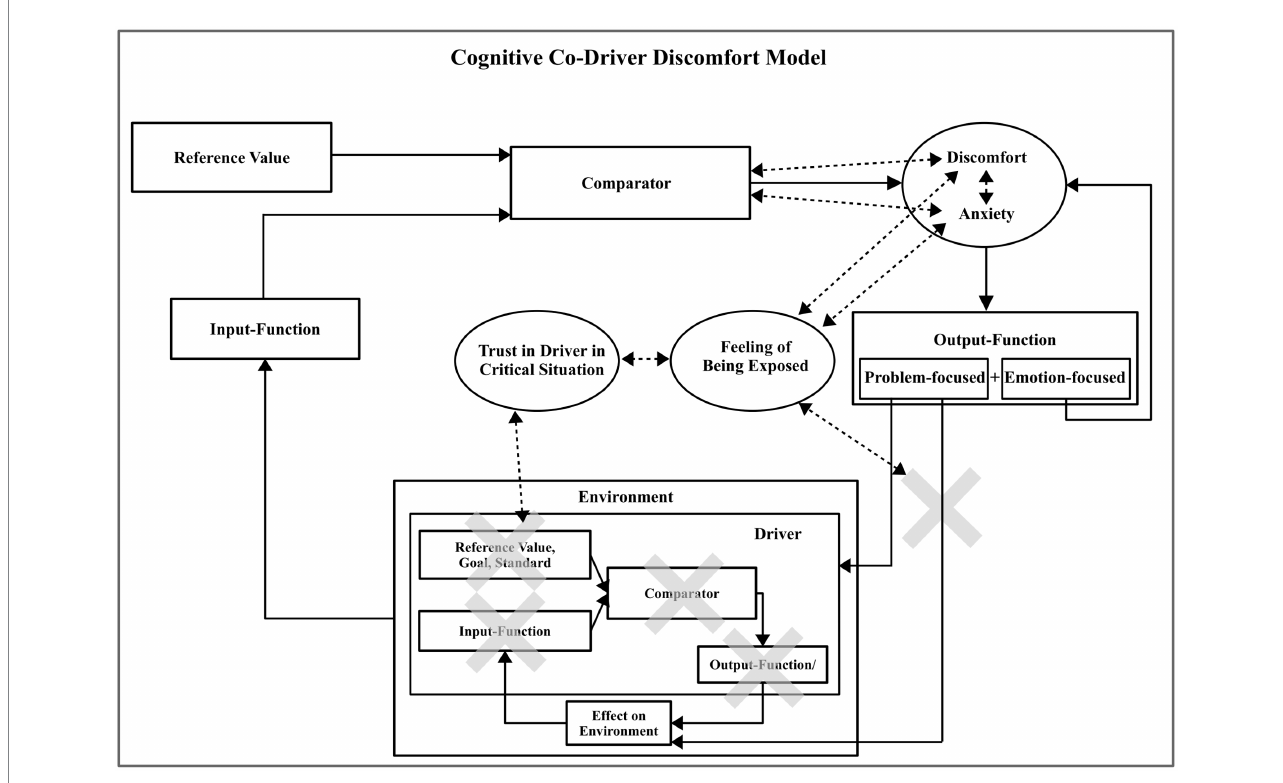
FIGURE 1 Cognitive passenger discomfort model based on Ittner et al. (2020). From the perspective of the passenger, the driver is part of the environment. Aspects in the model that are only sparsely or not available for passengers and therefore contribute to their discomfort are represented by gray crosses. The dashed arrows show correlated emotional concepts that were verified in the original study (Ittner et al.,